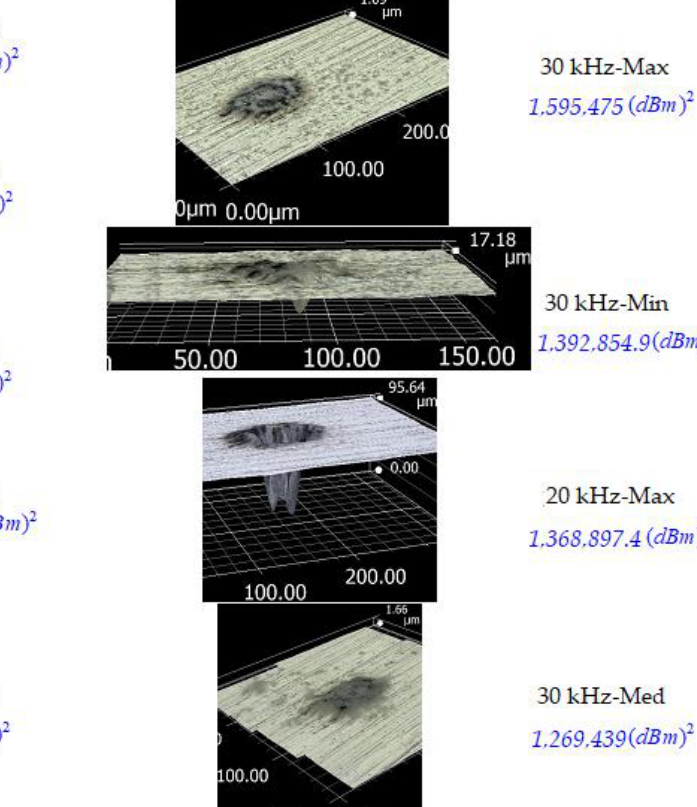
Figure 7. 3D microscope images and values of the RFP 2 of the recorded RF spectra for the “Part 2” experiments. The 3D images are on the left side, and the values of the received RFP 2 are on the right side, in blue, running from the highest RFP 2 to the lowest value.